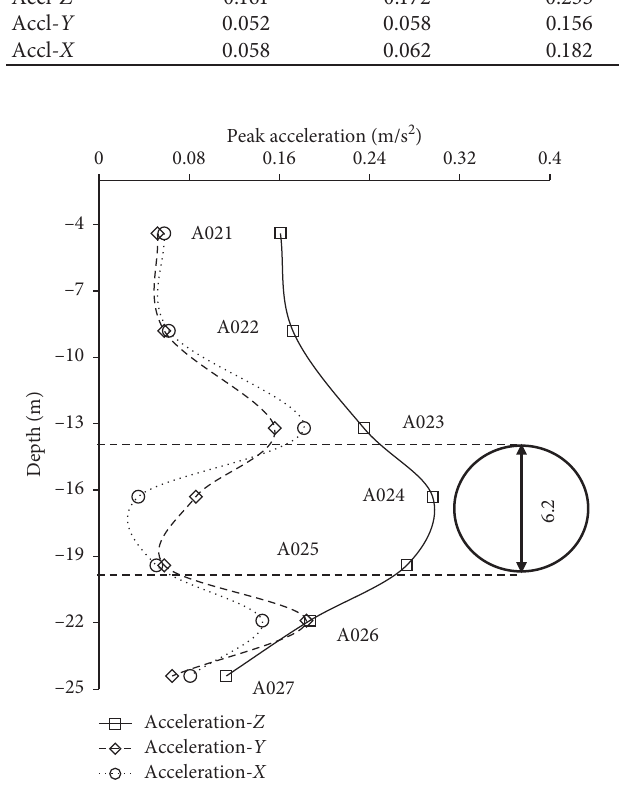
Figure 11: Distribution of accelerations along the depth direction at A021 ∼